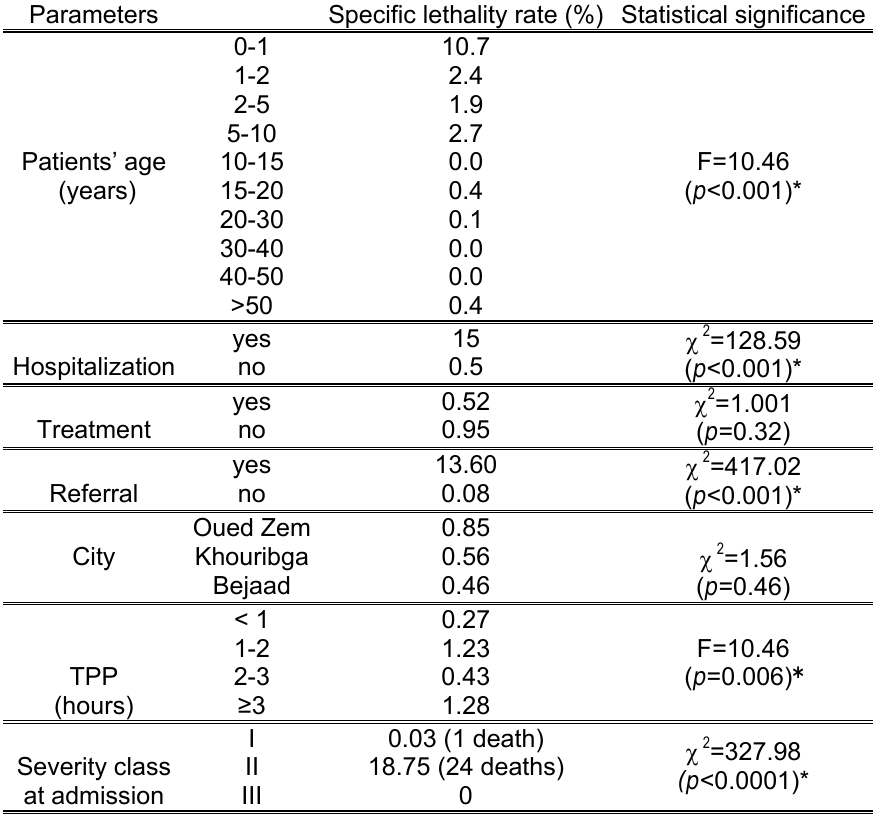
Table 1. Specific lethality rate according to parameters that influenced